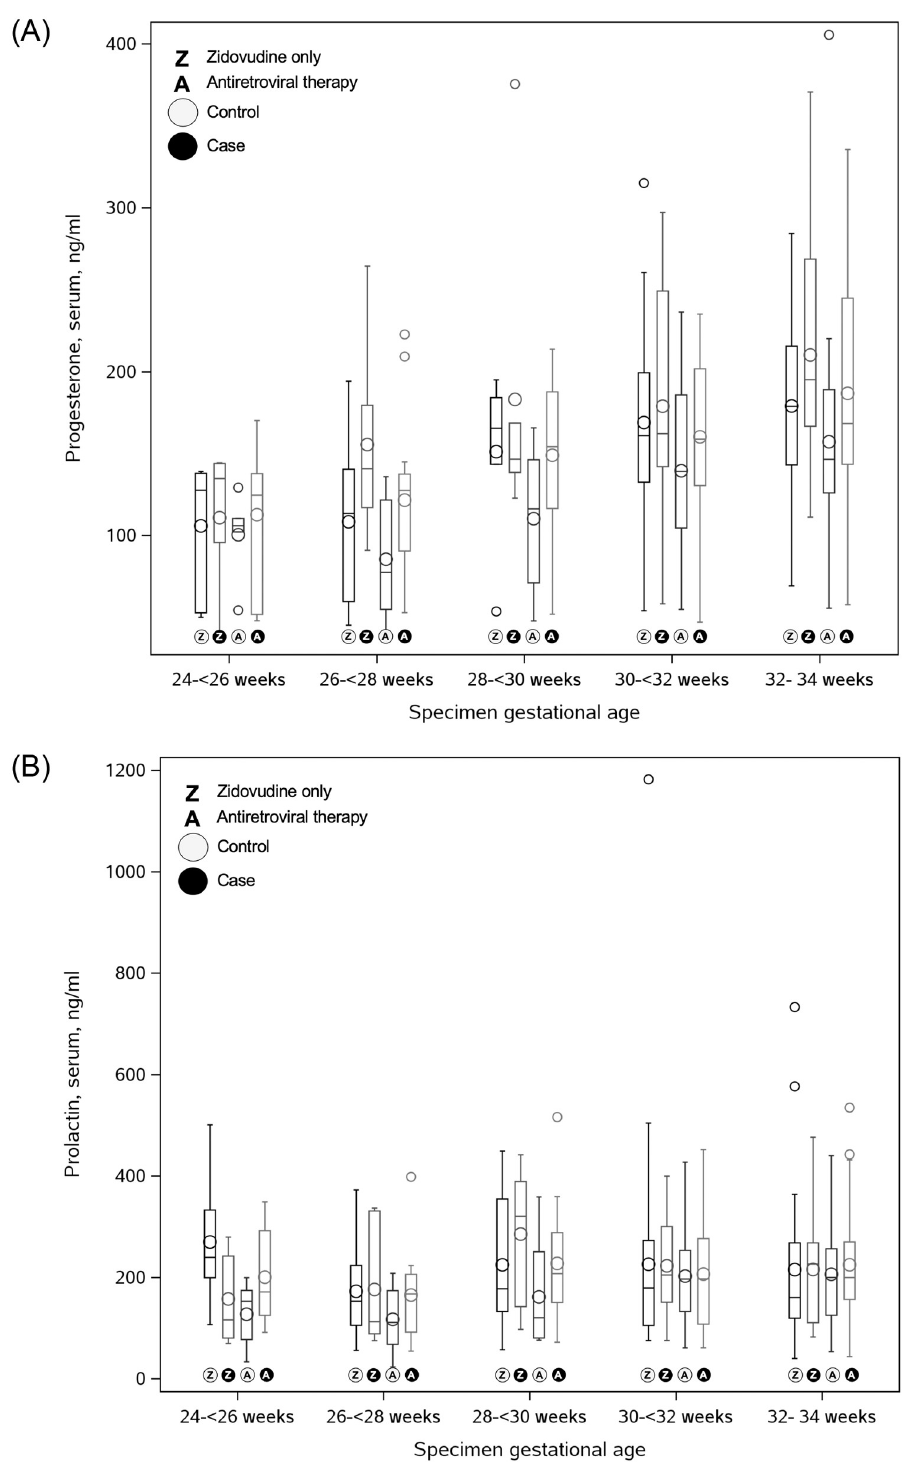
Fig 2. Distribution of progesterone (A) and prolactin (B) by antenatal antiretroviral regimen and gestational age at specimen collection. ZDV = zidovudine, ART = antiretroviral therapy.